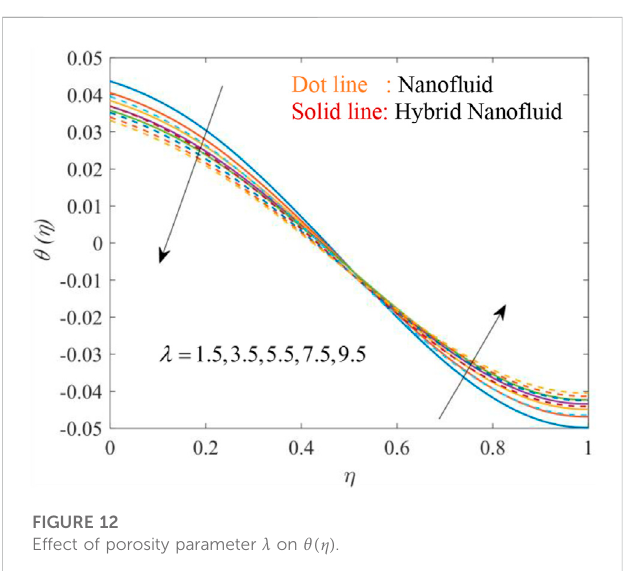
FIGURE 12 Effect of porosity parameter λ on θ ( η ) .